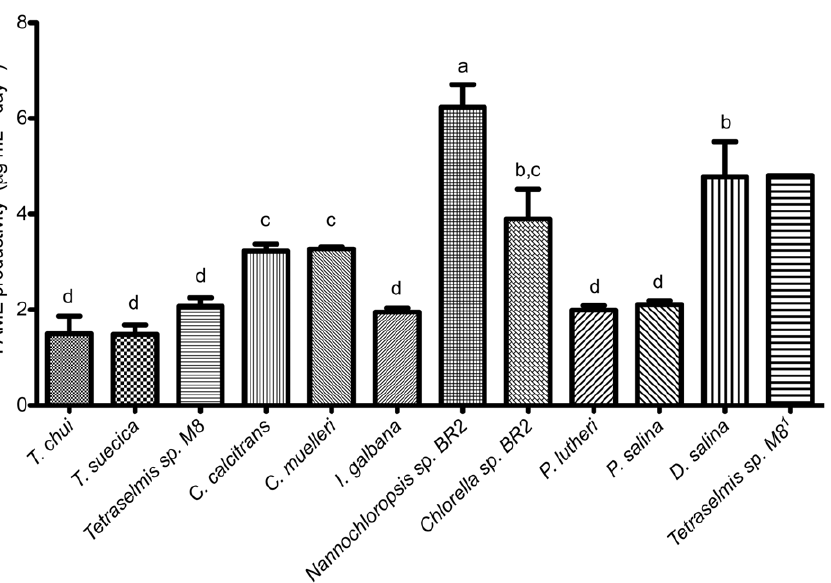
Figure 5. FAME levels of microalgae strains grown in batch culture (7 days growth + 2 days starvation by replacement of medium with seawater). Values shown are the averages of three biological replicates 6 SD (except Tetraselmis sp. 1 ). Different superscripts indicate significant difference at 95% level (ANOVA, Bonferroni’s test; P , 0.05). 1 Mid-scale outdoors culture.